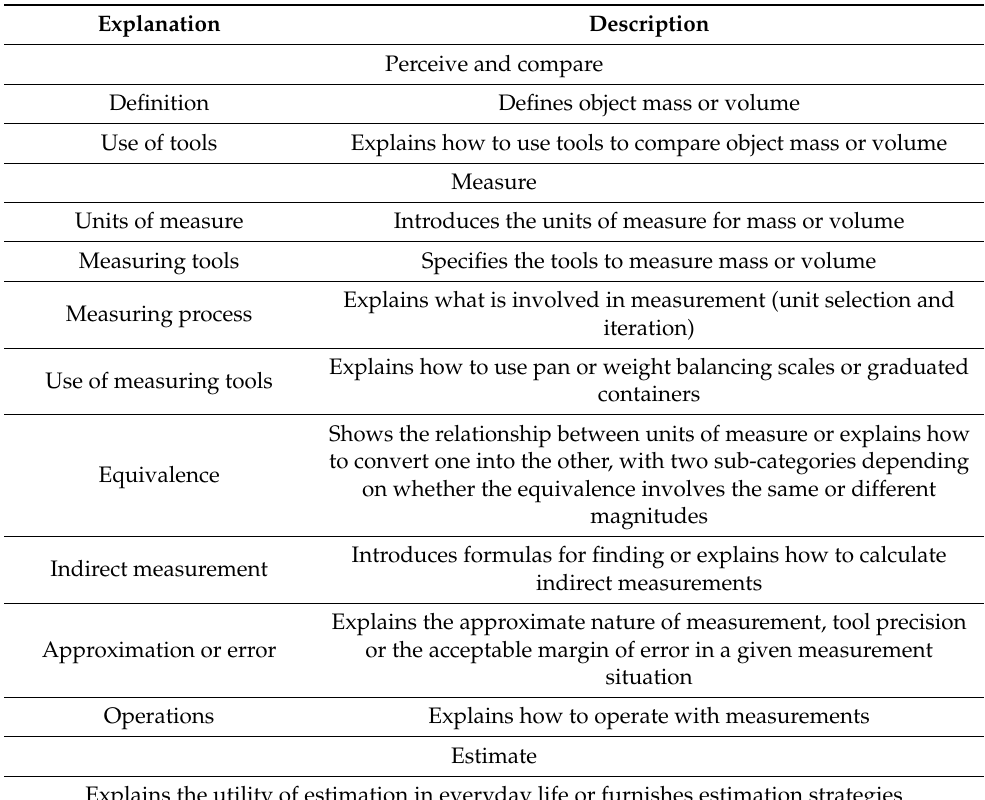
Table 3. Measurement skills addressed in